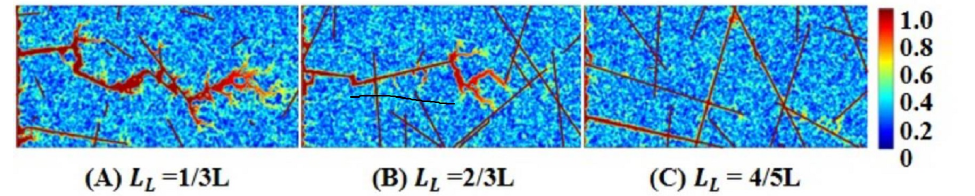
Figure 3. Effect of fracture length on wormhole structures in linear acidizing simulation.